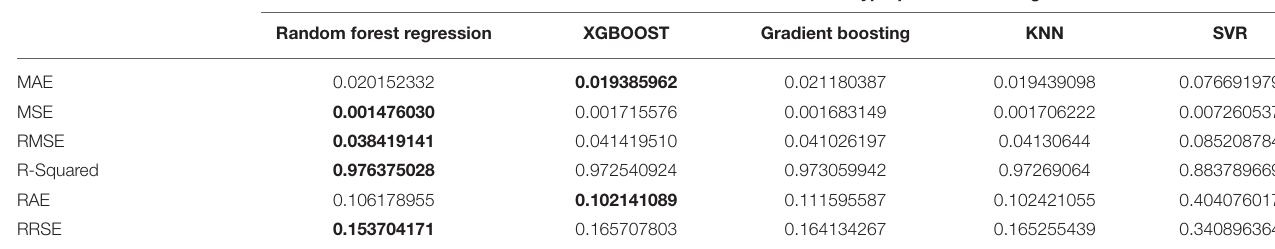
TABLE 6 | Prediction with Feature Selection and with hyperparameter tuning. Performance